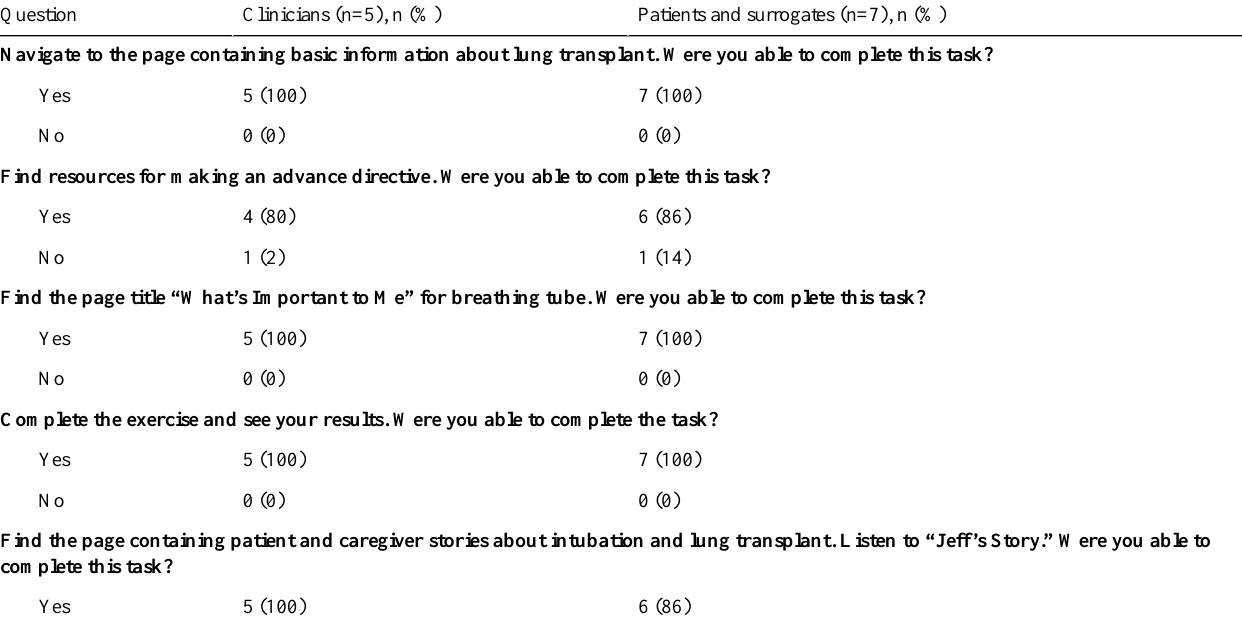
Table 4. Task completion